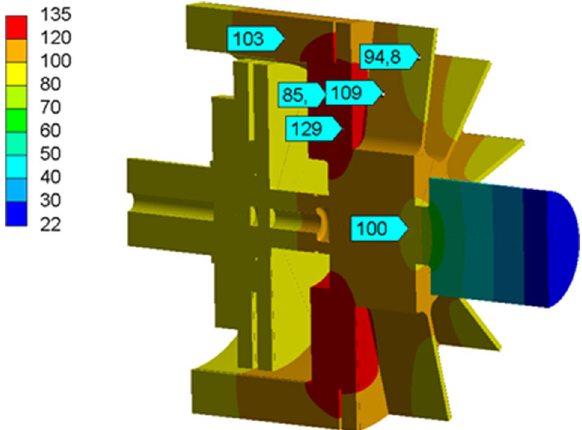
Fig. 6 Results of the steady state heat transfer simulation, Tempera- ture in °C